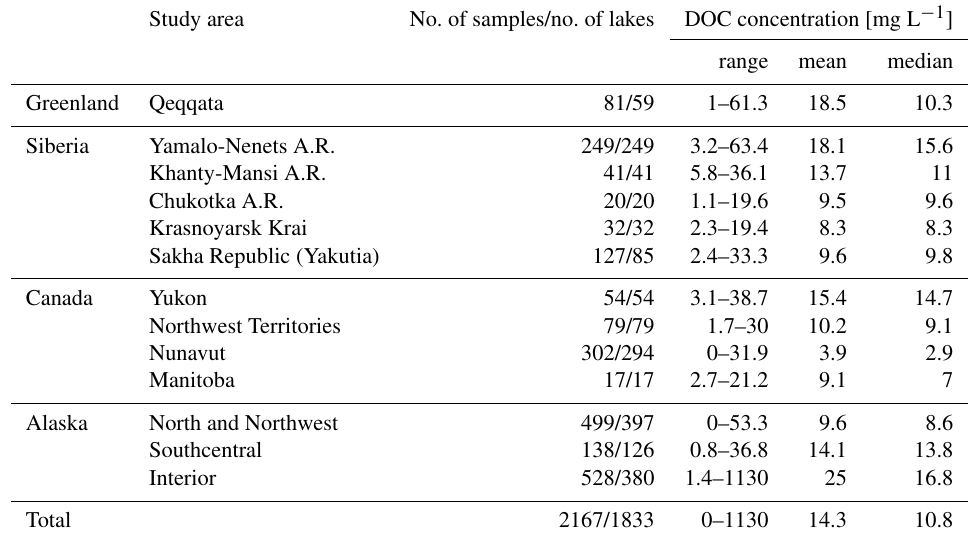
Table 3. DOC concentrations according to study